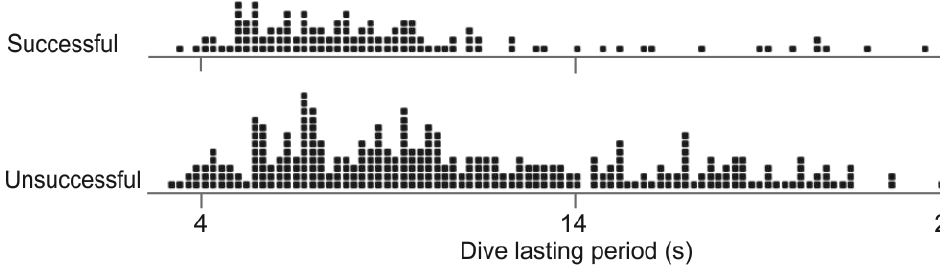
Figure 1. Frequency of successful and unsuccessful dive durations.